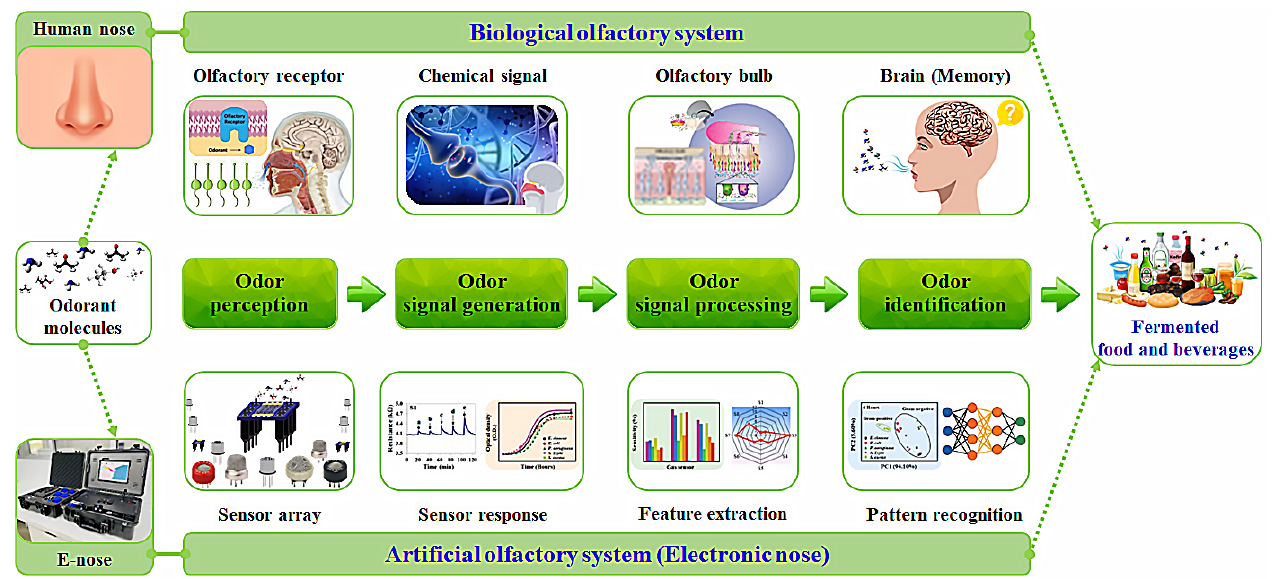
Figure 2. Schematic diagram of E-nose device versus biological olfactory system.